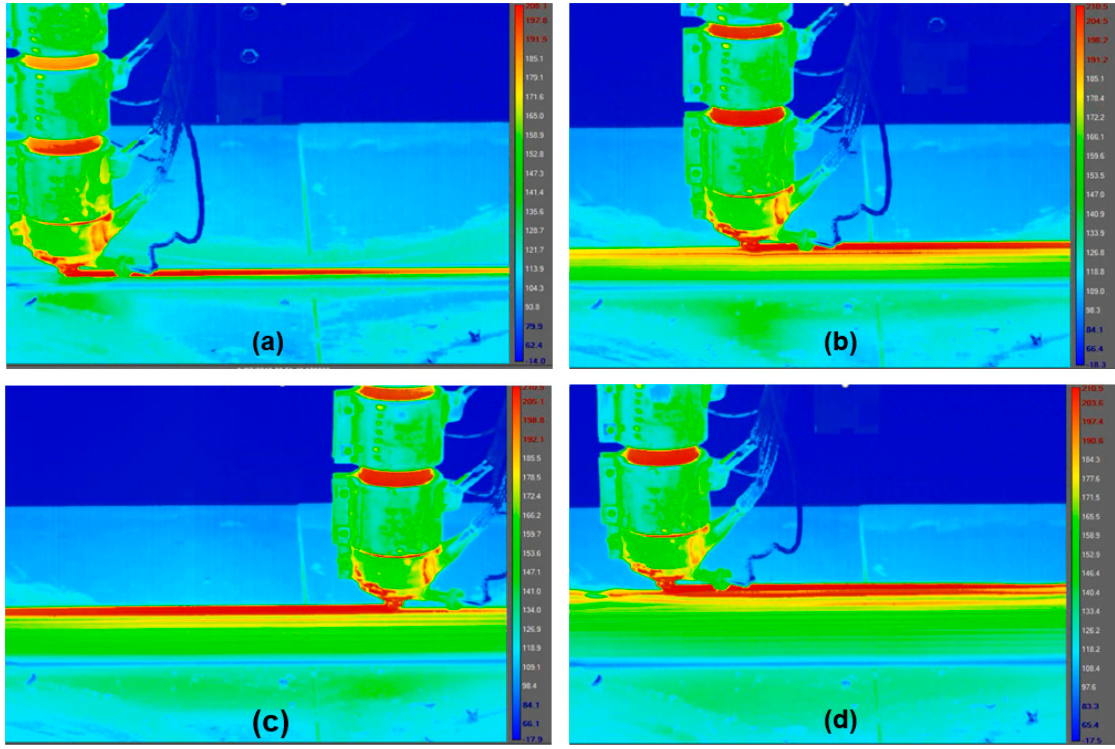
Figure 11. Snapshots of temperature profile recorded by the IR camera. A 700 mm long, 8 mm wide wall was printed with ABS.